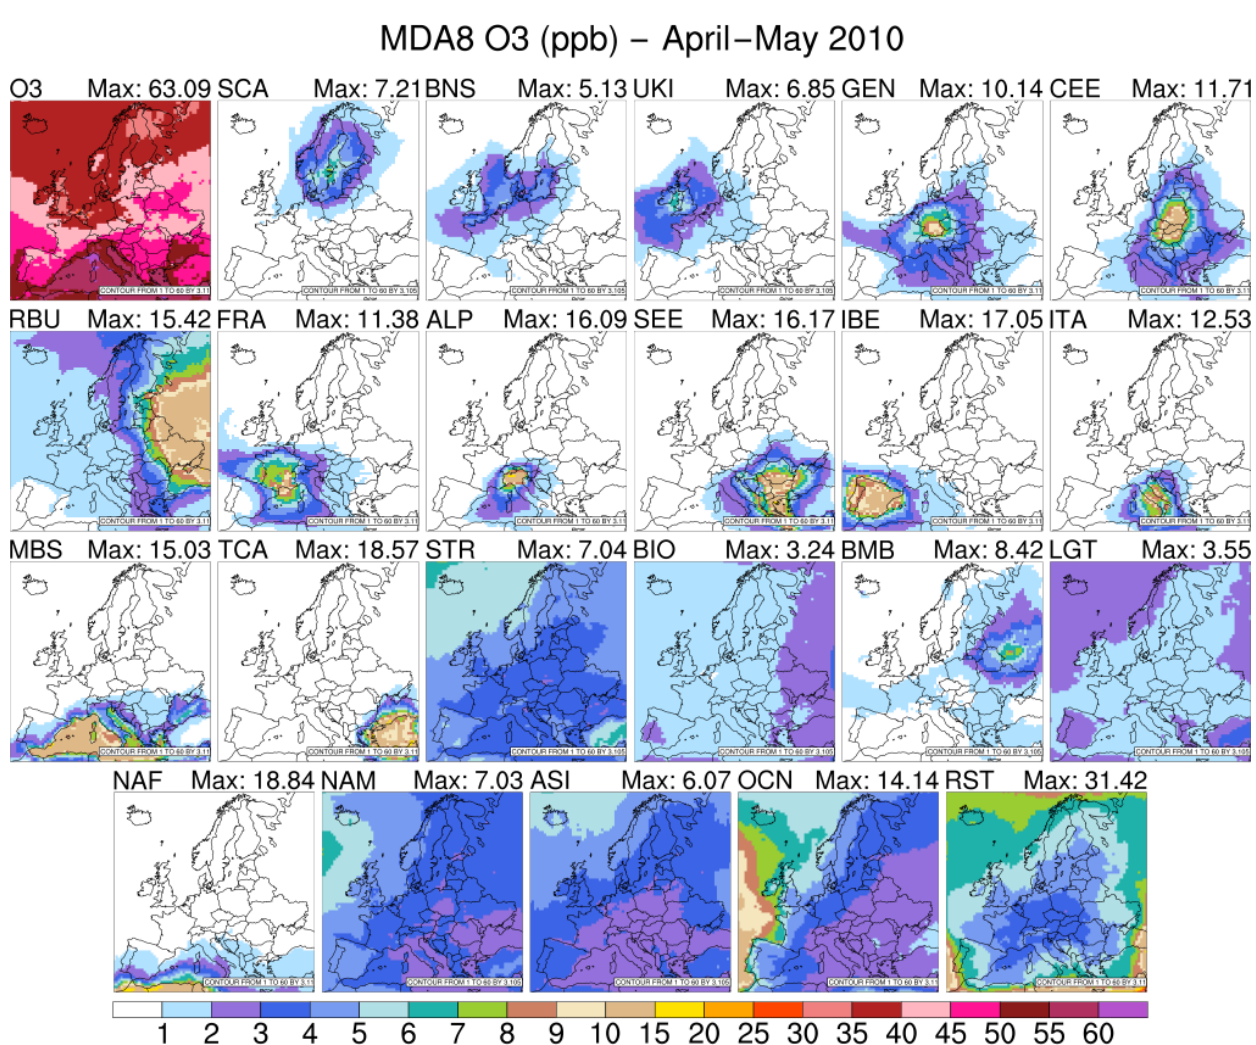
Figure 2. Contribution to MDA8 O 3 (ppb) of each O 3 source region and global source type for the April–May 2010 period.